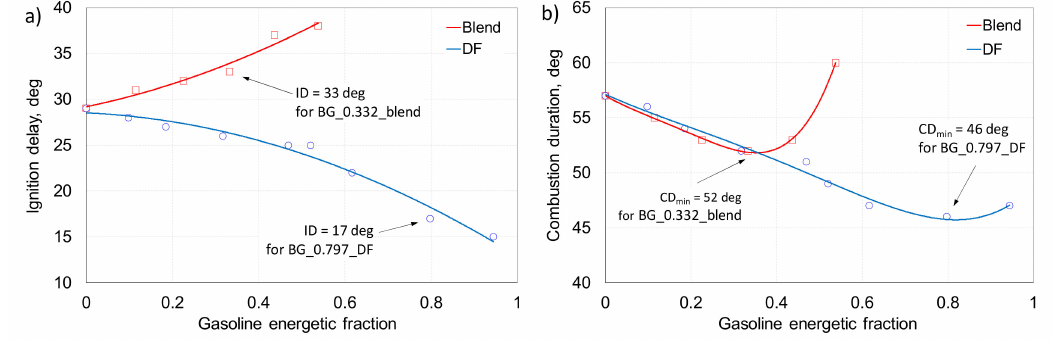
Figure 14. Stages of combustion, ignition delay ( a ) and combustion duration ( b ).